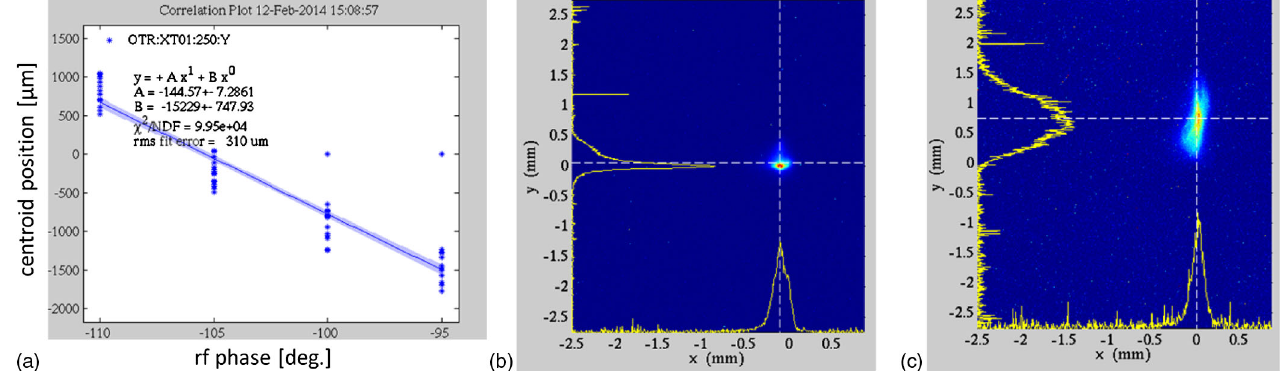
FIG. 17. Example of bunch measurements using XTA X -band detector: (a) calibration curve, transverse bunch centroid position-to-rf phase; (b) rf deflector off; (c) vertically streaked bunch profile observed on a Yttrium Aluminum Garnet